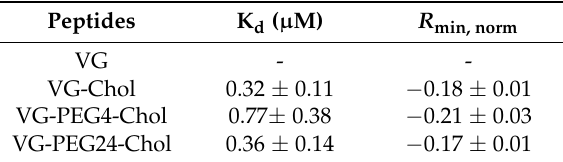
Table 3. Peptide affinity towards PBMC, assessed by di-8-ANEPPS fluorescence. The dissociation constant, K d and the asymptotic minimum value of R , R min , were obtained by fitting the experimental data to Equation (3). Values are means ± SEM of at least 3